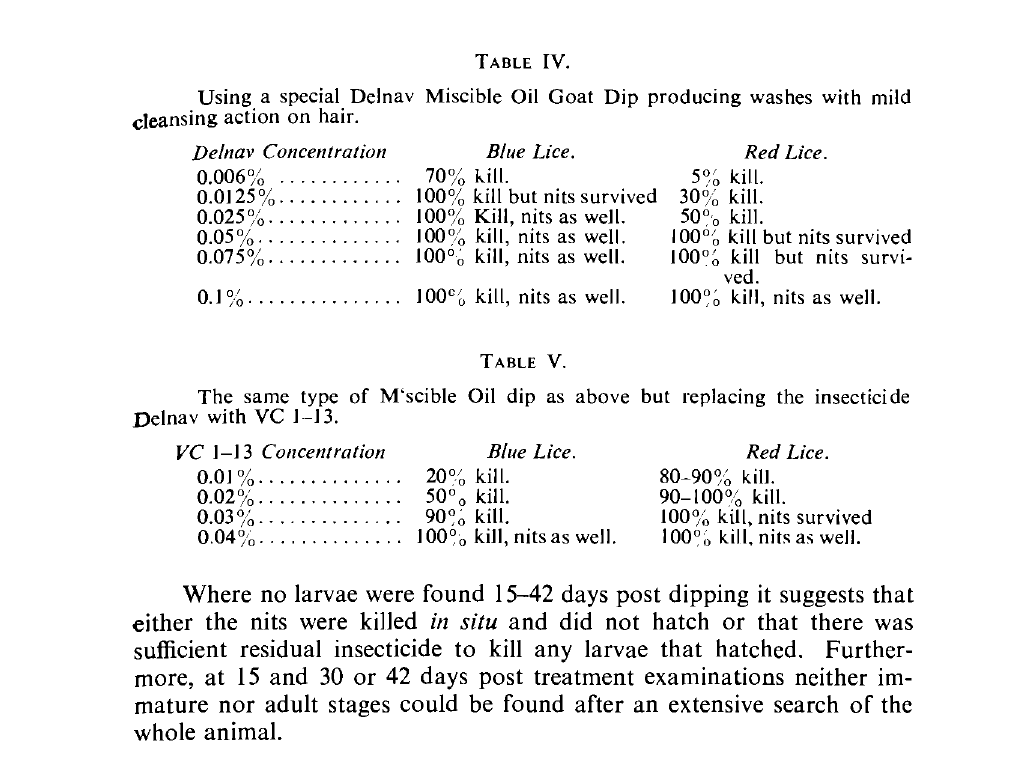
Using a special Delnav Miscible Oil Goat Dip producing washes with mild cleansing action on hair. Delnav Concentration Blue Lice. Red